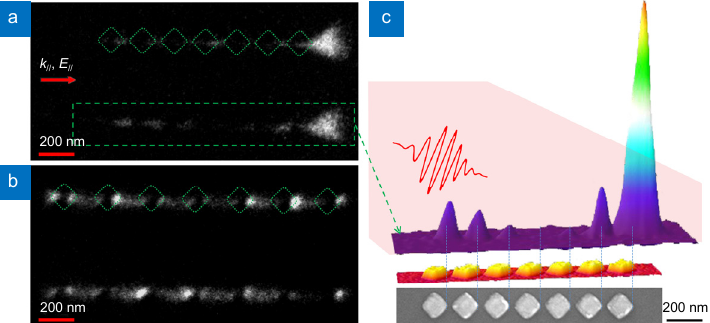
Fig. 4 | PEEM images of Au nanochains with different gap distances: ( a ) 30 nm and ( b ) 100 nm . The outlines of the nanochains are indicated by dotted lines. ( c ) 3-D surface plot of the photoemission intensity from one nanochain with the gap distance of 30 nm, A SEM image (bottom) and its corresponding 3-D surface plot (above the SEM image) are also presented to help indicate the location of the hotspots. The in-plane wave vector k // and polarization E // for the incident laser pulses are indicated in (a).